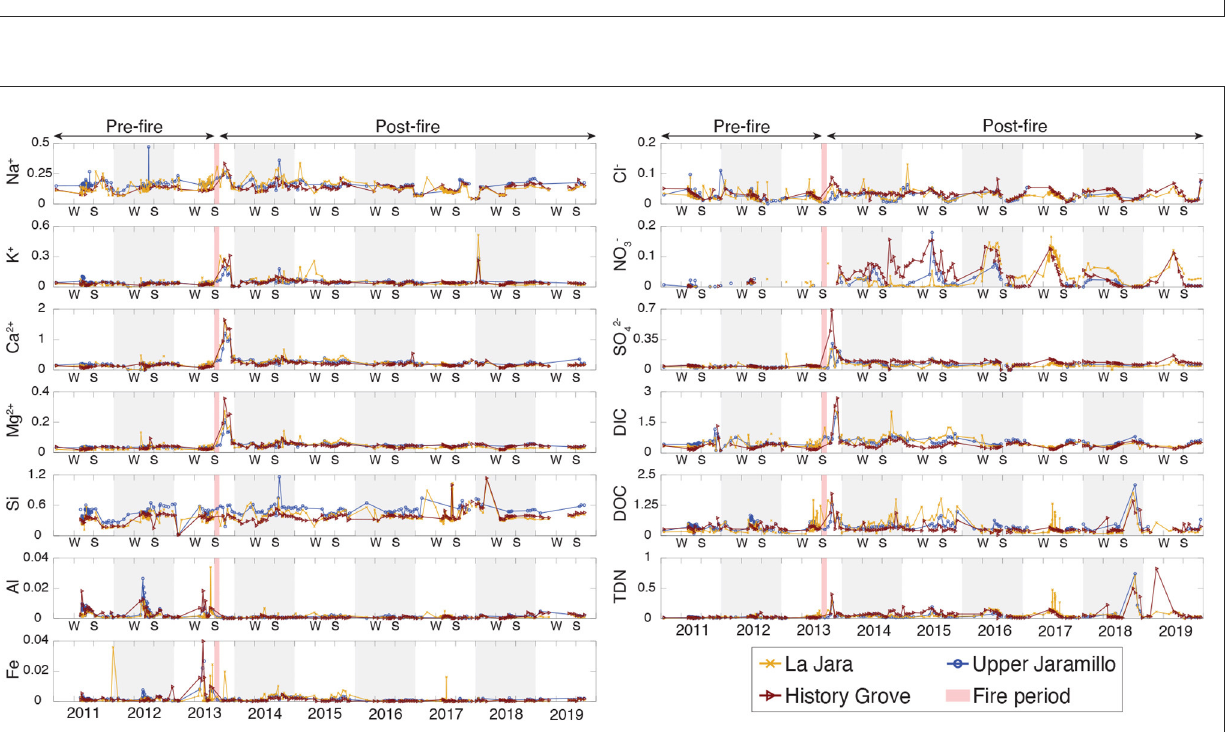
FIGURE3 (A) Daily averaged precipitation (top axis) and average daily temperature is shown in blue. (B) Snow water equivalent (SWE) for the water years before and after the fire. (C) Pre- and post-fire daily discharge of La Jara, History Grove, and Upper Jaramillo flumes. The dashed lines indicate the simulated data of discharge obtained from the ANN models for La Jara and History Grove Creeks. The shaded red region marks the timing of the Thompson Ridge Wildfire from May 31 through June 30, 2013.